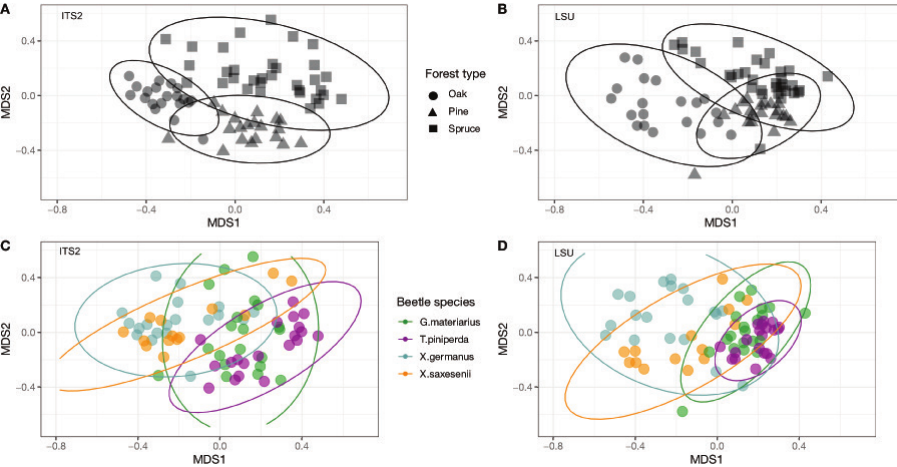
Figure 3. NMDS ordination plot of all specimens sampled with ITS2 and LSU D1-D2, based on the fungal community composition of the individual beetles. Shapes represent forest types and colours repre- sent beetle species. Stress for this graph fell within acceptable ranges